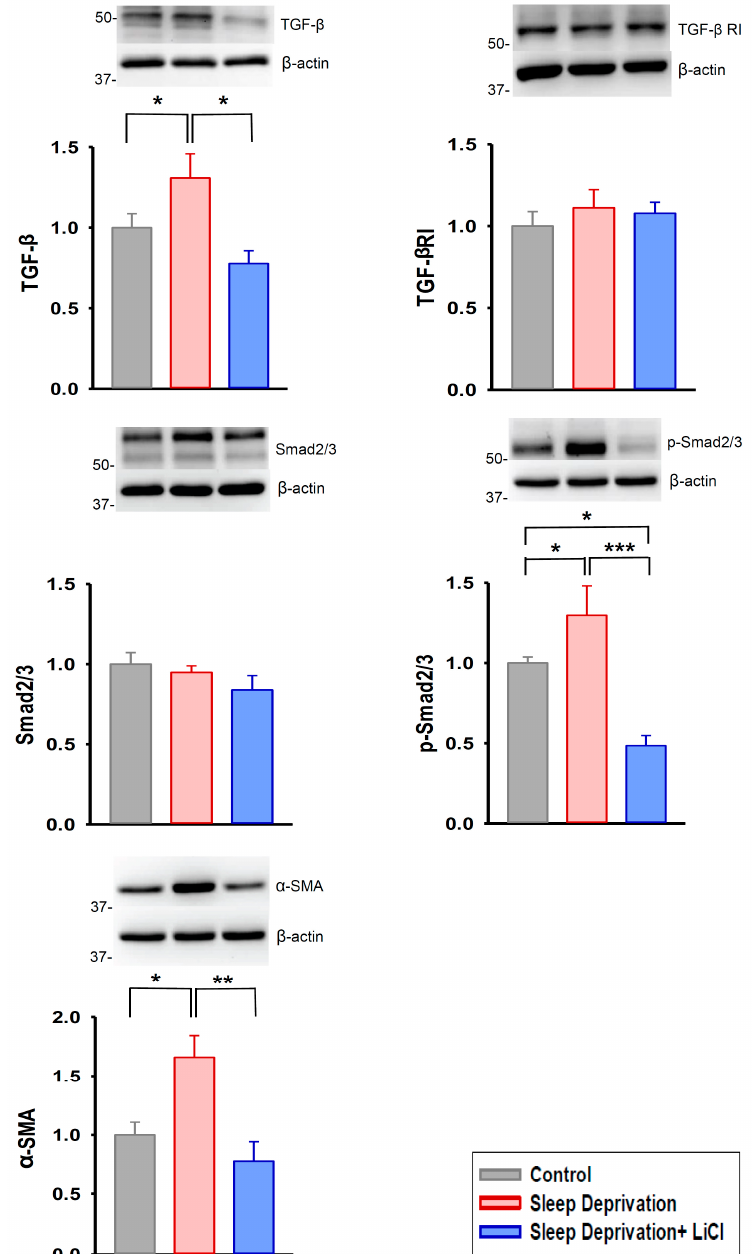
Figure 3. Transforming growth factor beta (TGF- β ) signaling pathway in REM sleep deprivation with and without lithium treatment. The REM sleep-deprived hearts ( n = 5) had greater expression levels of TGF- β , phosphorylated Smad 2/3, and α -smooth muscle actin ( α -SMA) compared with the control ( n = 5) and lithium-treated REM sleep-deprived ( n = 5) hearts. * p < 0.05; ** p < 0.01; *** p < 0.001.